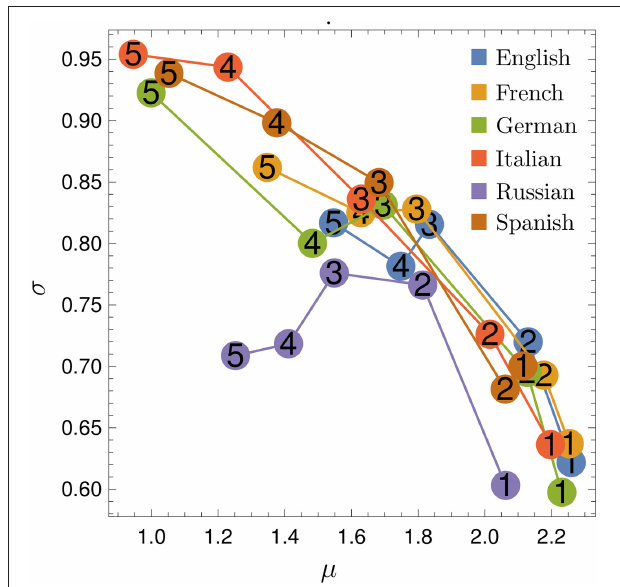
FIGURE 3 | Fitted parameters for rank diversity. Parameters µ and σ for the sigmoid fit of the rank diversity d ( k ), for all languages (indicated by colors) and N -values (indicated by numbers). We observe an (approximate) inversely proportional relation between µ and σ